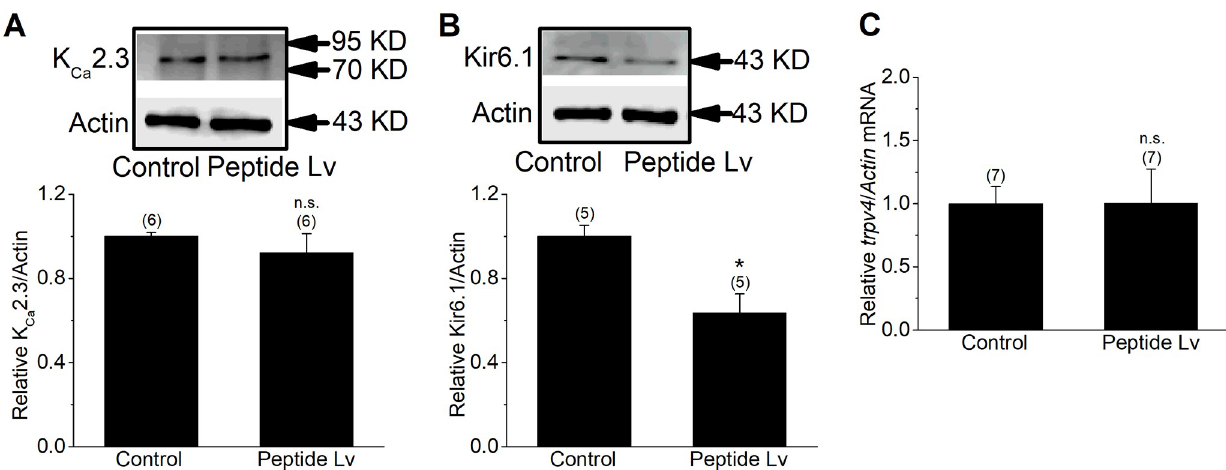
Fig 2. Peptide Lv does not increase the expressions of K Ca 2.3, Kir6.1, or TRPV4 in ECs. Endothelial cells were treated with PBS (vehicle control) or peptide Lv (500 ng/ml) for 4 hours and processed for immunoblotting or qPCR. Peptide Lv did not increase (A) K Ca 2.3, (B) Kir6.1, or (C) TRPV4 in cultured HUVECs. Student’s t -test was used for statistical analyses; � p < 0.05.